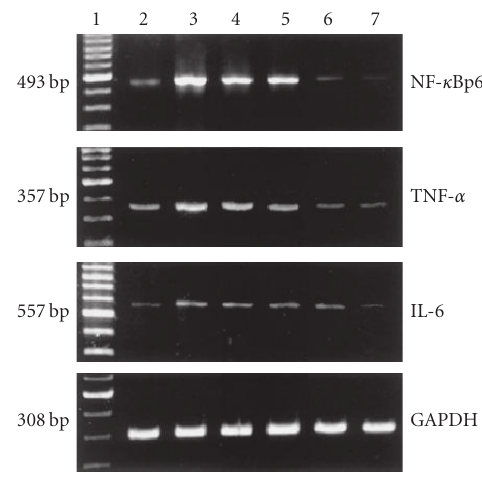
Figure 6: TNF- α , NF- κ Bp65, IL-6, and GAPDH mRNA expressions in colon tissues. Lane 1: 100 bp marker, Lane 2: the N group, Lane 3: the M group, Lane 4: the 5-ASA group, Lane 5: the LD group, Lane 6: the MD group, and Lane 7: the HD group.